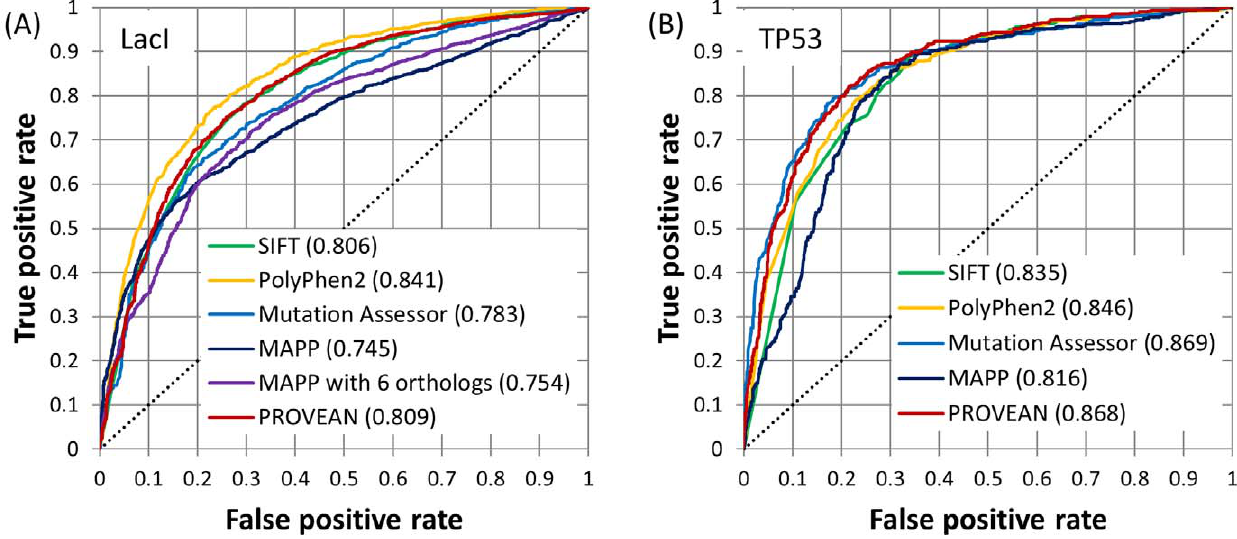
Figure 6. ROC curves of different prediction tools for single amino acid substitutions in (A) E.coli lac repressor protein and (B) human TP53 tumor suppressor protein. The AUC values are shown in the legend. The top two performers for LacI were PolyPhen-2 and PROVEAN, and those for TP53 were Mutation Assessor and PROVEAN. doi:10.1371/journal.pone.0046688.g006 PLOS ONE |